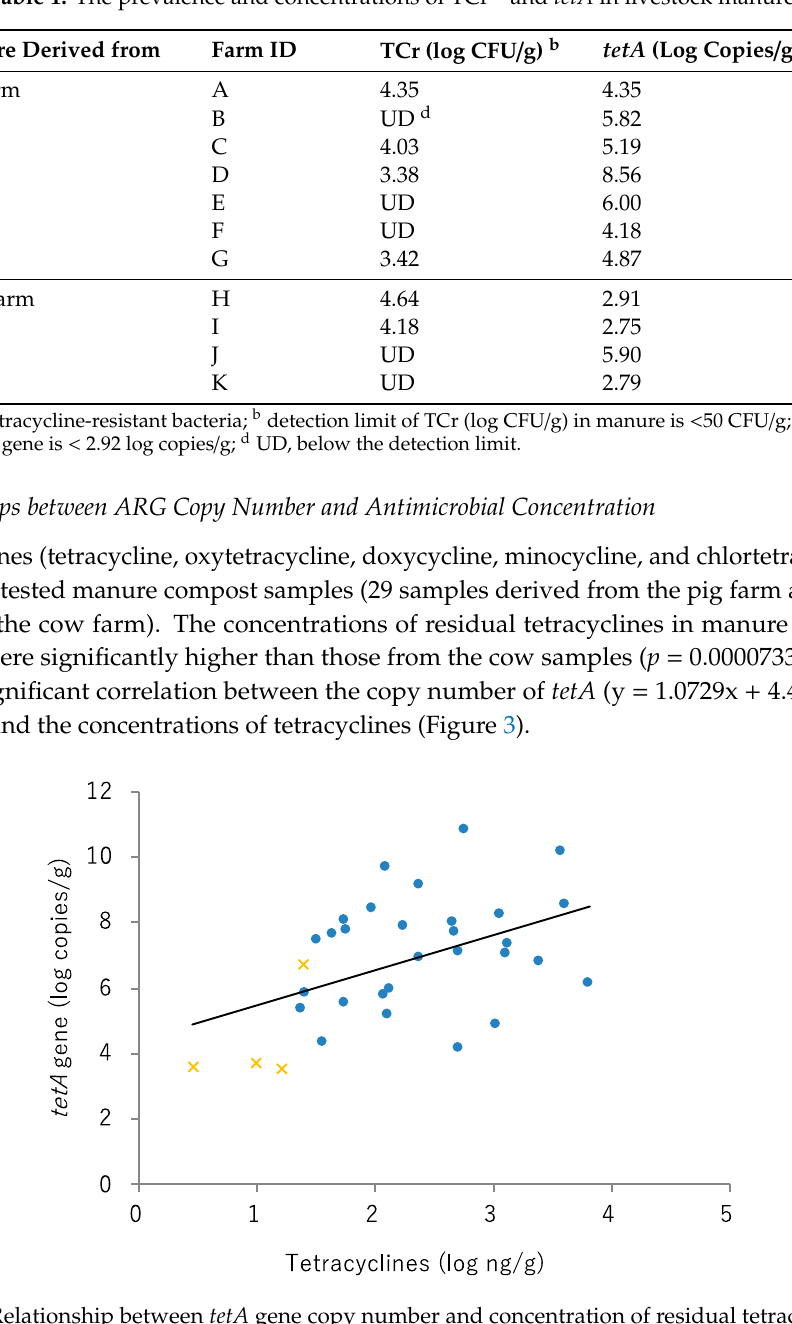
Table 1. The prevalence and concentrations of TCr a) and tetA in livestock manure Manure derived from